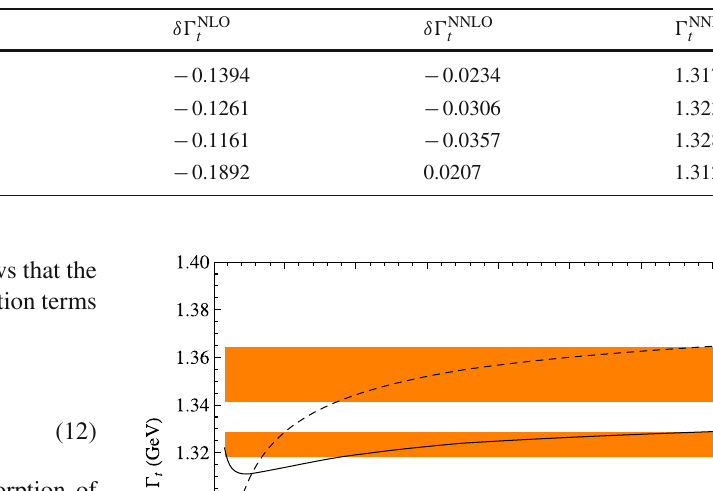
Table 1 The LO decay width (cid:5) LO t together with the NLO and NNLO QCD correction terms δ(cid:5) NLO t and δ(cid:5) NNLO t